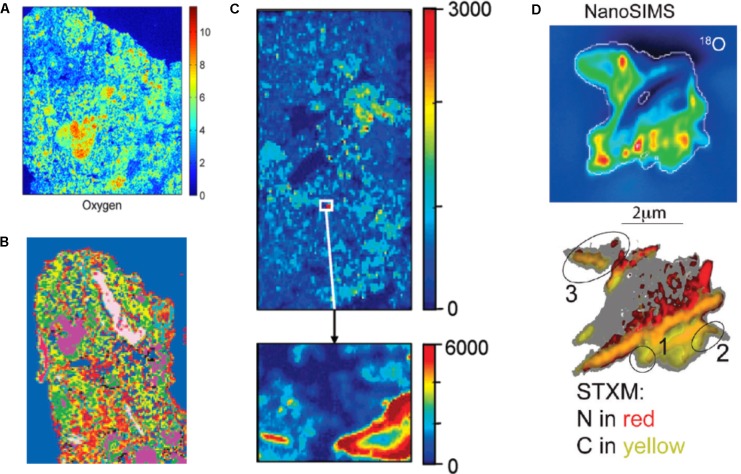
Illustrative examples of various chemical measurements that are now routinely carried out on 2D cross-sections through soil samples: (A) SEM-EDX mapping of the distribution of oxygen in a section through a calcareous soil from Scotland. The intensity of the color indicates the concentration of oxygen (Adapted from Hapca et al., 2015). (B) Cluster map showing the large heterogeneity of carbon forms within a soil micro-assemblage from Nandi Forest (Kenya) determined by NEXAFS in combination with scanning transmission X-ray microscopy (STXM). The field of view is 5.4 μmm by 7.5 μm (adapted from Lehmann et al., 2008. Reprinted with permission). (C) Synchrotron-based μXRF maps of Cu in a calcareous soil vineyard soil from Burgundy (France). The large map on top (2 by 4 cm) was obtained with a 0.3-mm spot size, the small map at the bottom (1.5 by 1 mm) with a 20-μm spot size. The color, from blue to red, is correlated with the Cu concentration (Adapted from Jacobson et al., 2007. Reprinted with permission). (D) NanoSIMS map of 18O in a soil aggregate (top) and C and N map of the same aggregate obtained by STXM (bottom). NEXAFS spectra were obtained in the three circled regions, whereas in the gray zones the sample was too thick to get NEXAFS spectra or was free of OM (Reprinted with permission from Remusat et al. (2012). Copyright [2012] American Chemical Society).